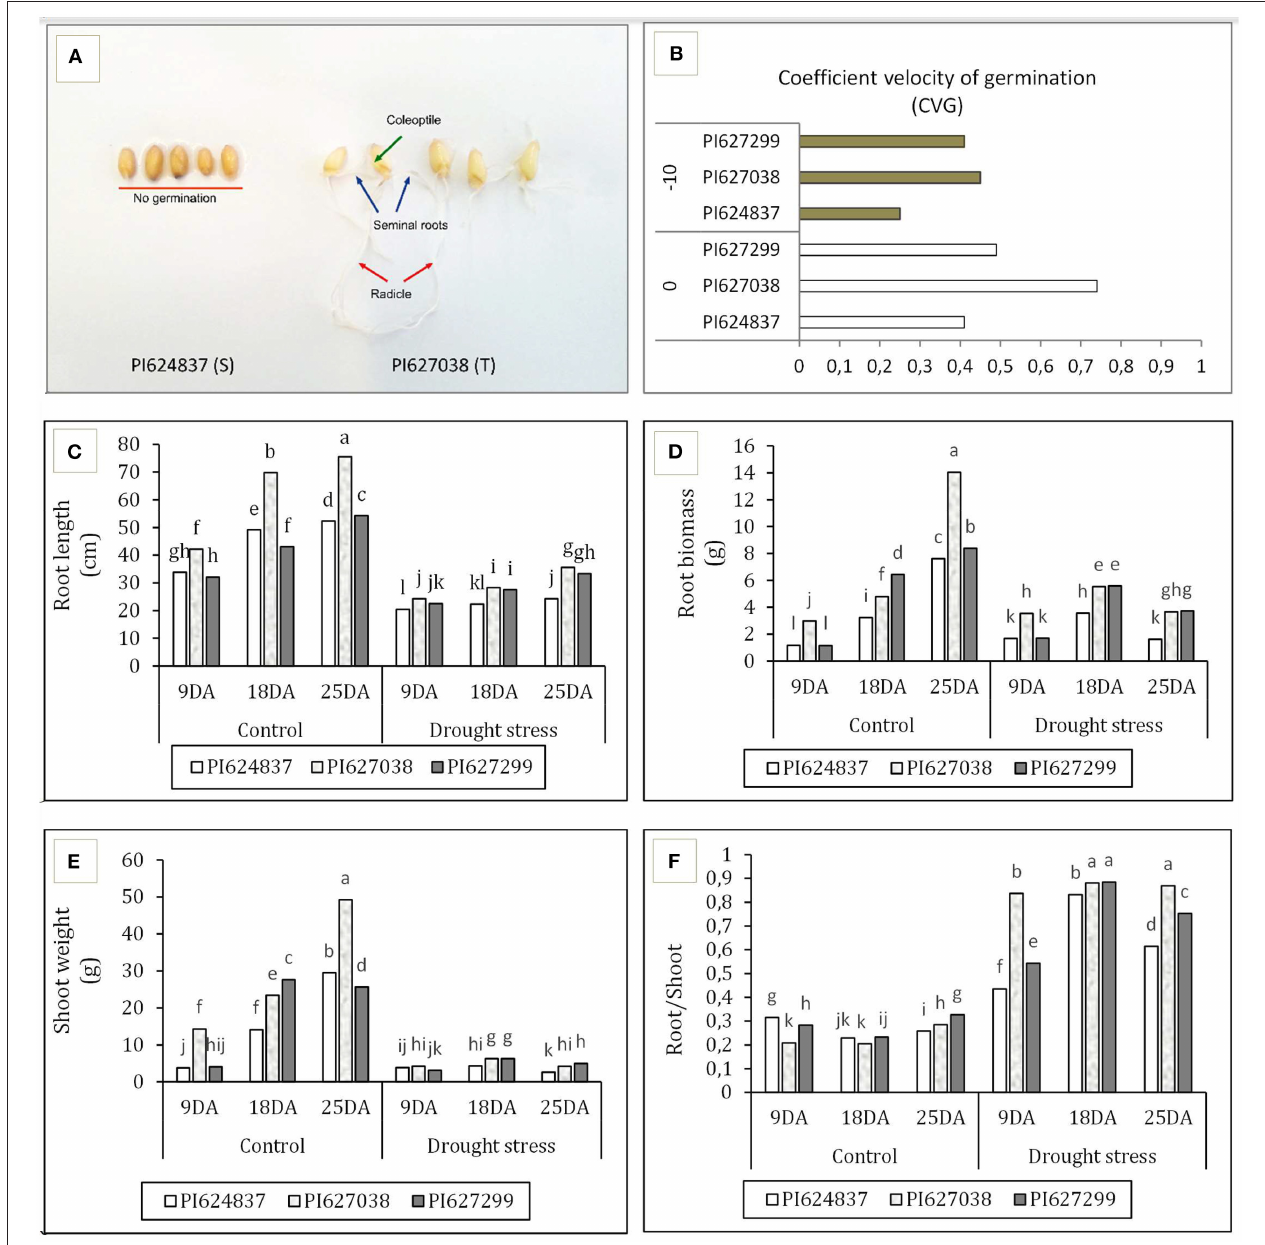
FIGURE 1 | Germination study of selected wheat genotypes. (A) Response to simulated water deficit at − 12 bar, the tolerant genotype PI627038 is showing root development including radicle, seminal roots; and shoot development including coleoptile emergence, while no germination observed in susceptible genotype PI624837. (B) Coefficient velocity of germination (CVG) at − 10 bar. (C) Root length. (D) Root weight. (E) Shoot weight. (F) Shoot/root ratio. T, drought-tolerant; S, drought-susceptible; DA, days after applying water-deficit stress. Treatments are grouped based on Duncan multiple range